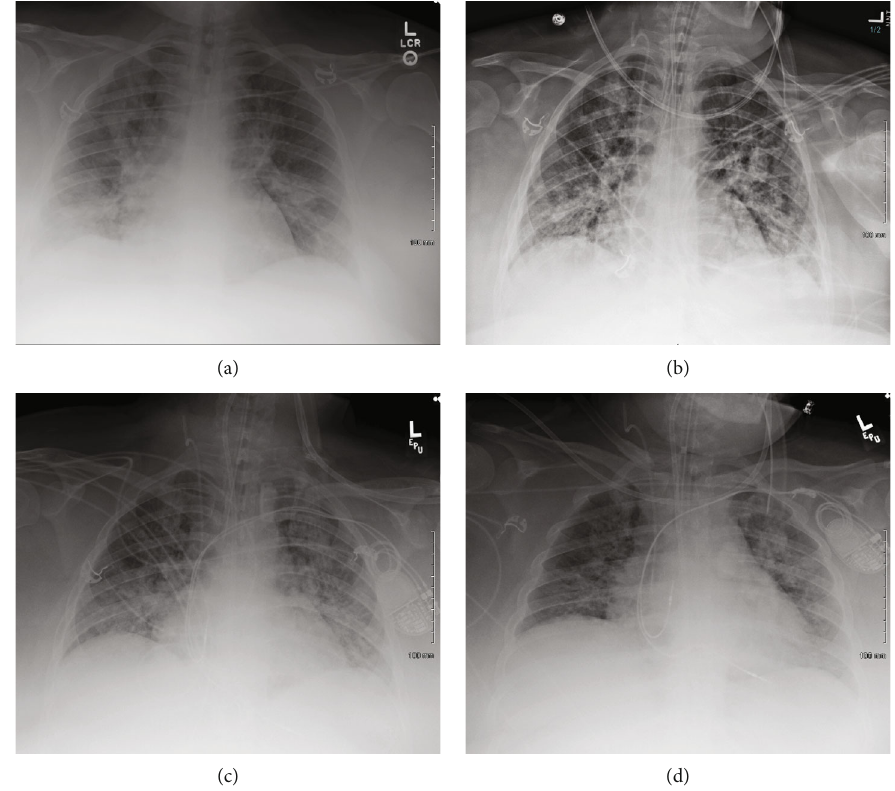
Figure 1: Progression of lung fi ndings on chest radiography in postpartum patient with severe COVID